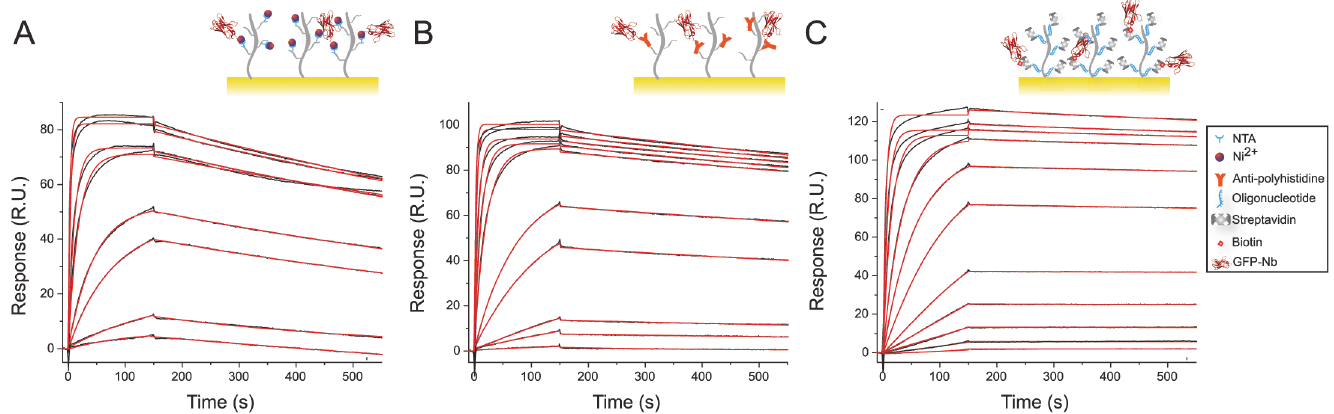
Fig 3. GFP:GFP-Nb complex. Binding of GFP to GFP-Nb immobilized on Ni:NTA (A), anti-polyhistidine antibody on CM5 (B) and streptavidin on CAP chip (C). Black lines are raw data and the red lines are the fitting to a 1:1 binding model. Depicted sensorgrams were obtained for GFP concentration of 0.1, 0.5, 1, 5, 10, 50, 100, 200, 500, 1000 nM (from bottom to top curve).